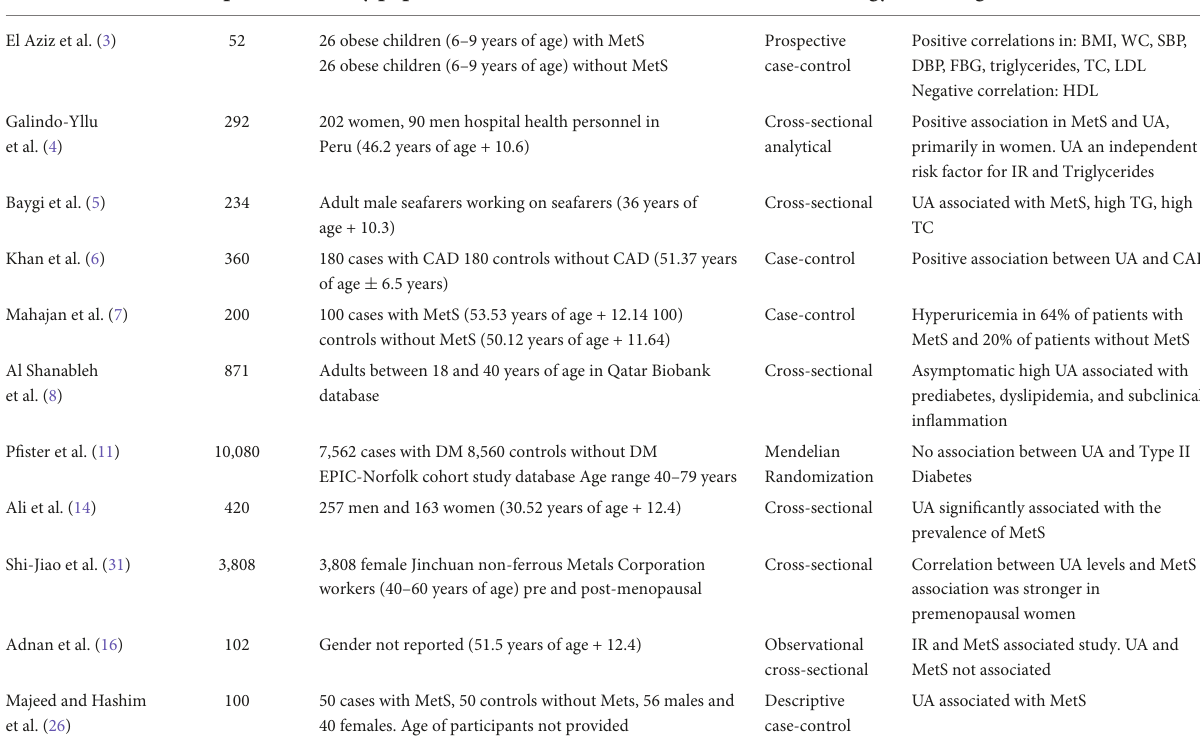
TABLE 4 Summary of similar studies regarding UA and